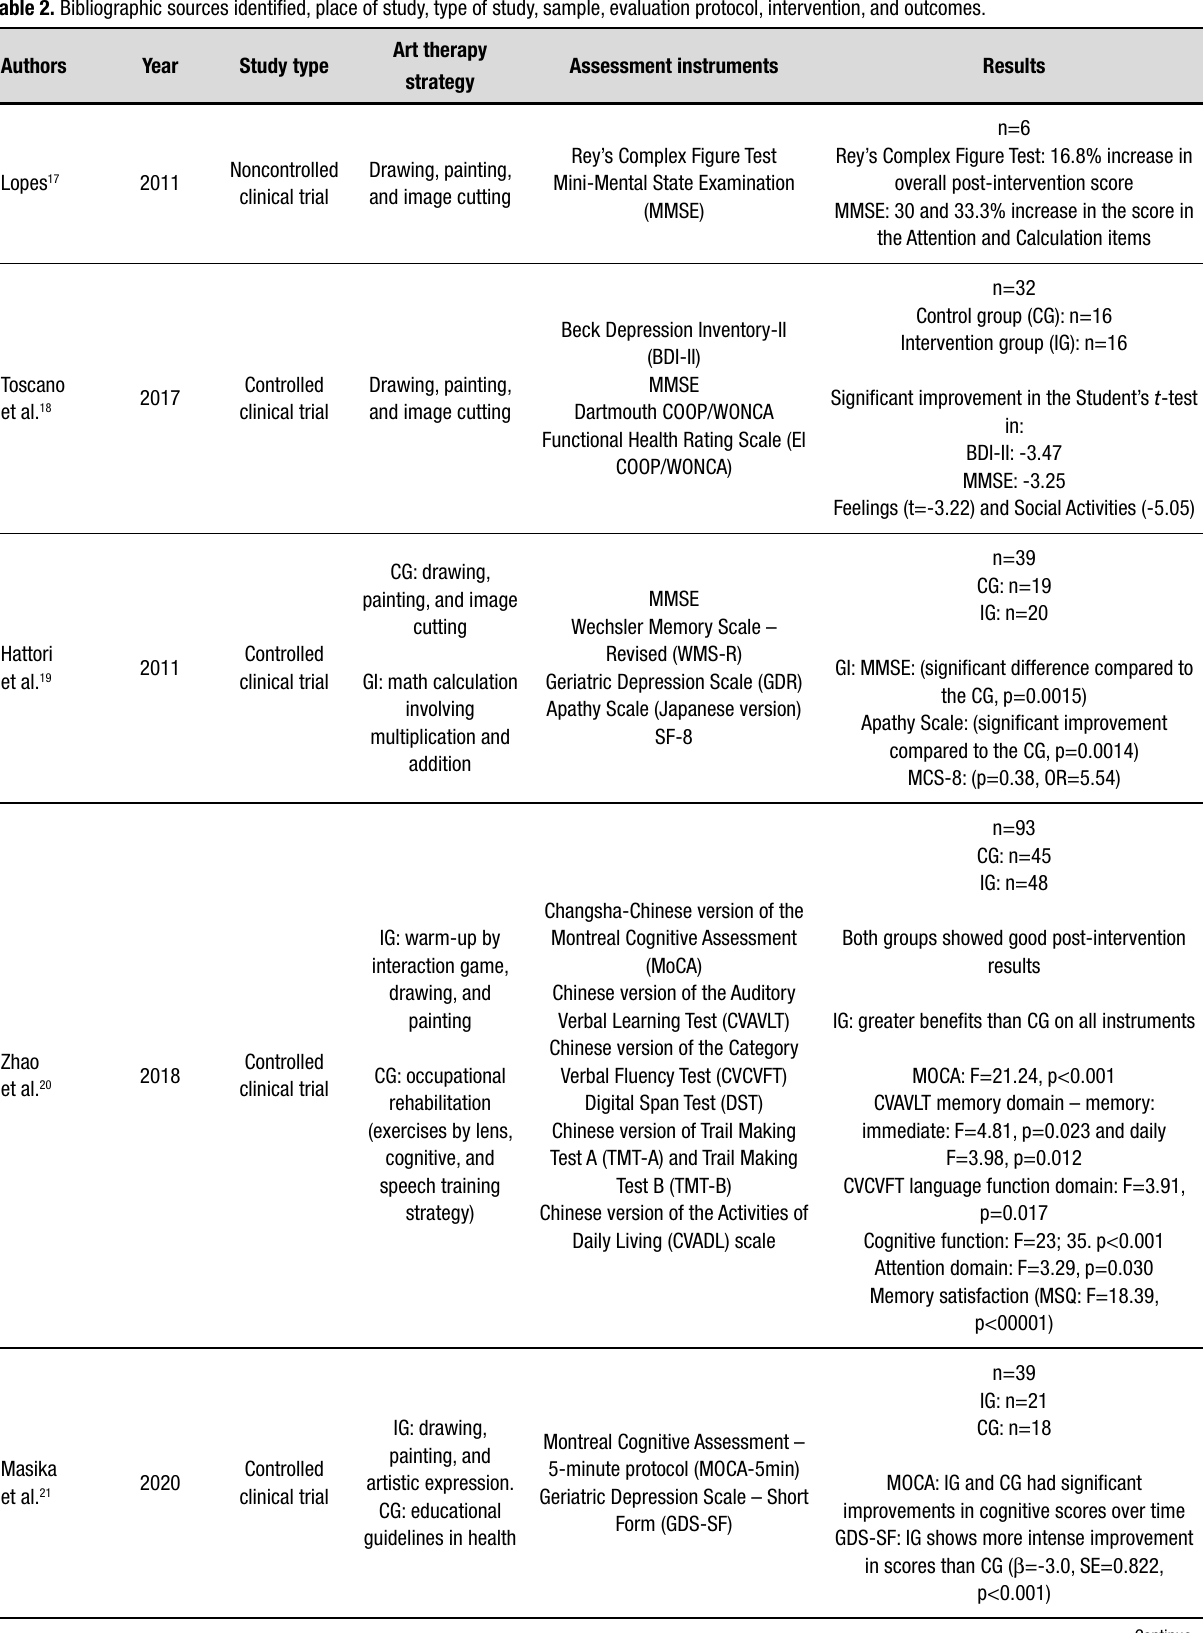
Rey’s Complex Figure Test: 16.8% increase in overall post-intervention score MMSE: 30 and 33.3% increase in the score